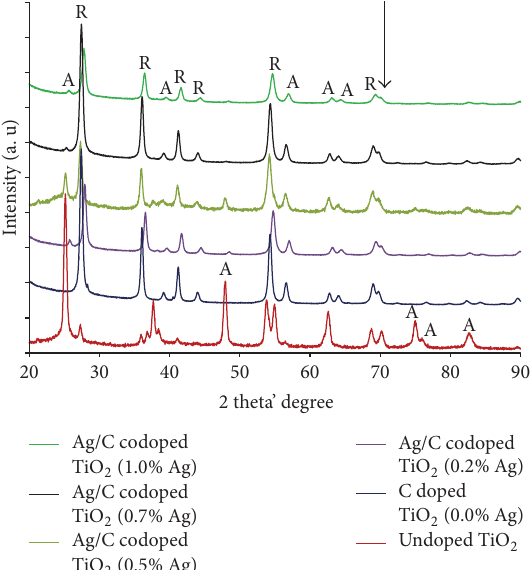
Figure 1: FTIR spectra of undoped TiO 2 and Ag/C codoped TiO 2 photocatalysts with different Ag contents.